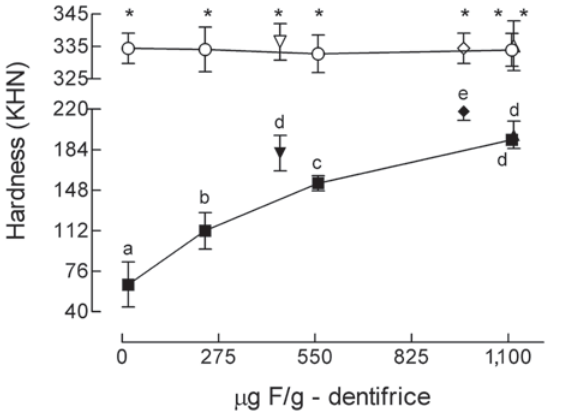
Figure 1- Surface hardness according to dentifrice.